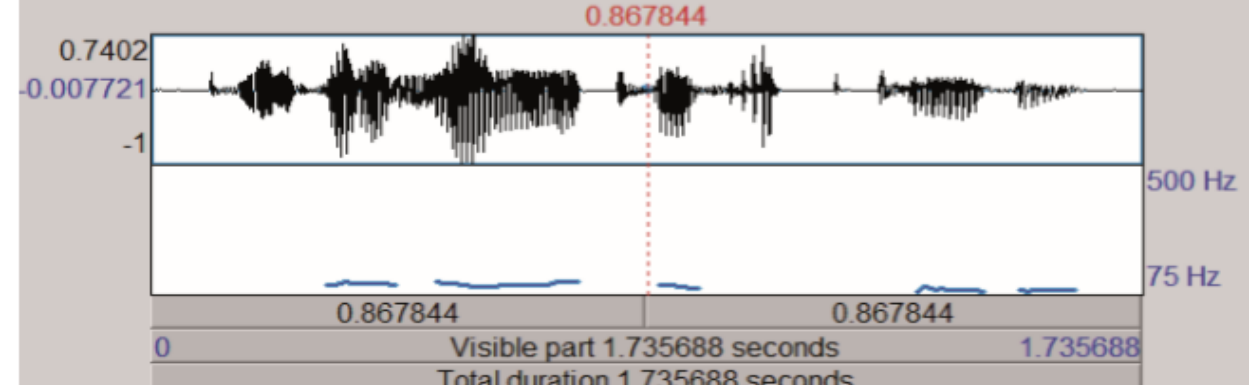
Fig.6 Pitch contour for